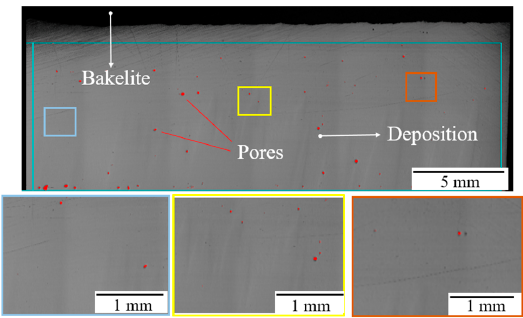
Figure 12. Cross section and porosity analysis of the 4340 deposition.